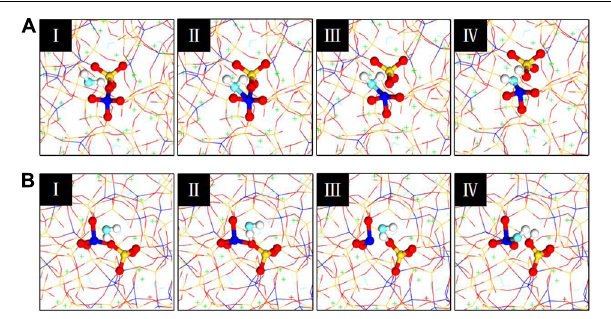
FIGURE 9 | Evolution of molecular structures for the chemical dissociation of water: (A) mechanism 1; (B) mechanism 2.